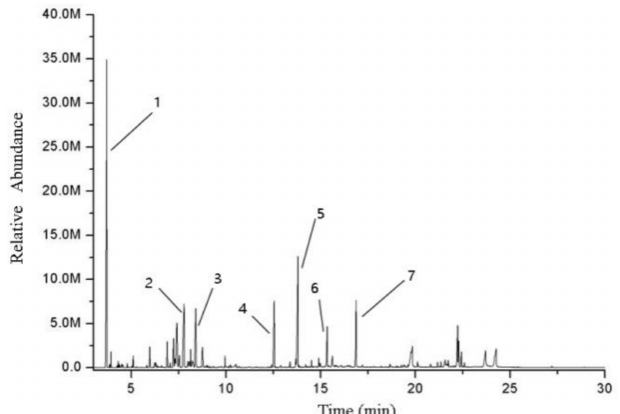
Figure A1. The total ion chromatograms of aroma components of SEOs by